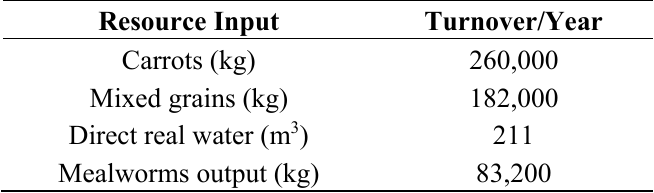
Table 1. Resource use per year of the mealworm farm considered in the